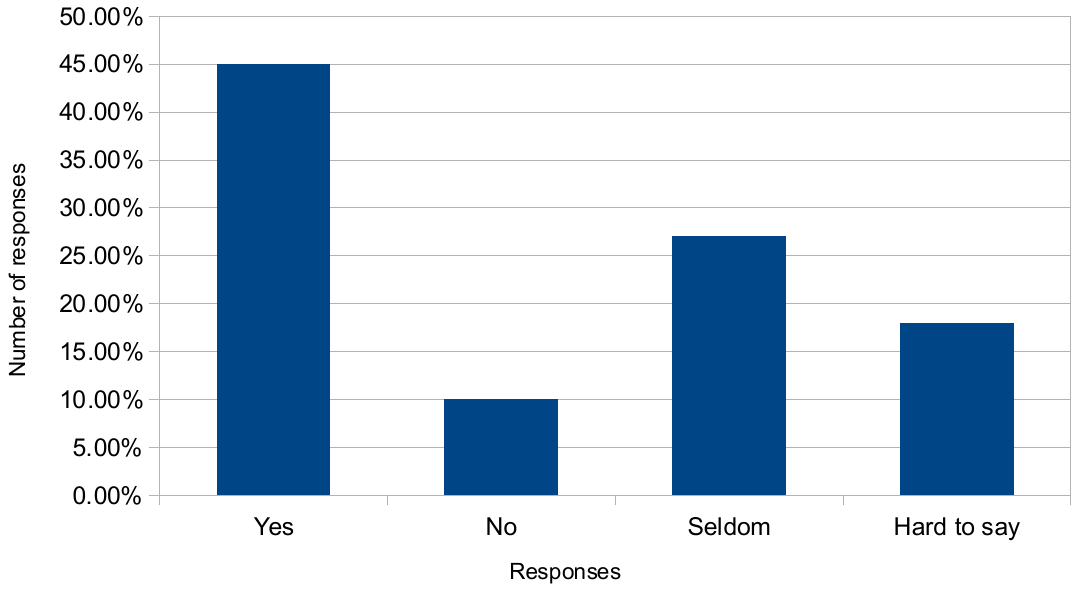
Figure 1. Ability to recognize the symptoms of psychomotor disorders in children in the school